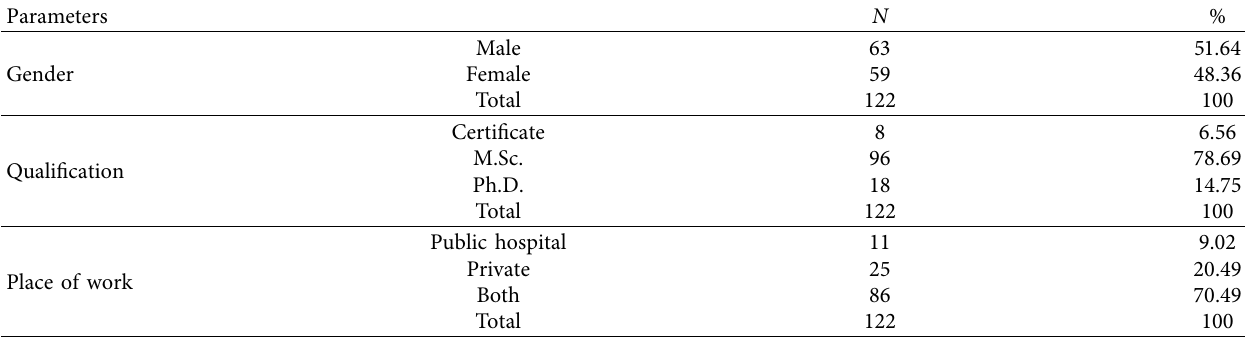
Table 1: Demographic data of the